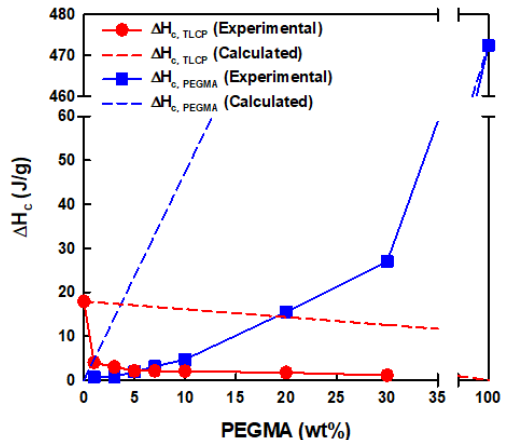
Figure 7. Experimental and calculated crystallization enthalpies ( Δ H c, TLCP and Δ H c, PEGMA ) of TLCP and PEGMA components in the blends as a function of the PEGMA content. Table 2. Characteristic melting and crystallization transition temperatures and enthalpies of neat TLCP, neat PEGMA, and TLCP / PEGMAr blends in di ff erential scanning calorimetry (DSC) thermograms. Sample